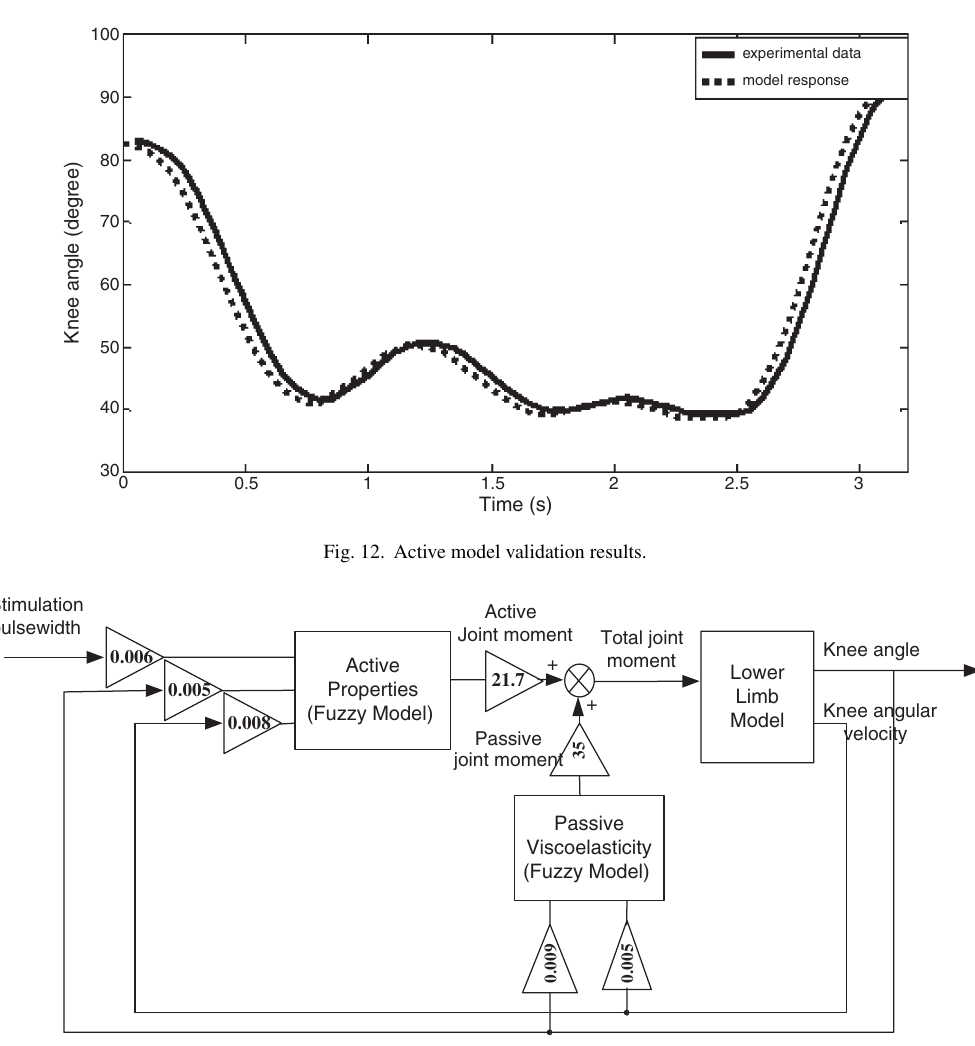
Fig. 13. Complete knee joint